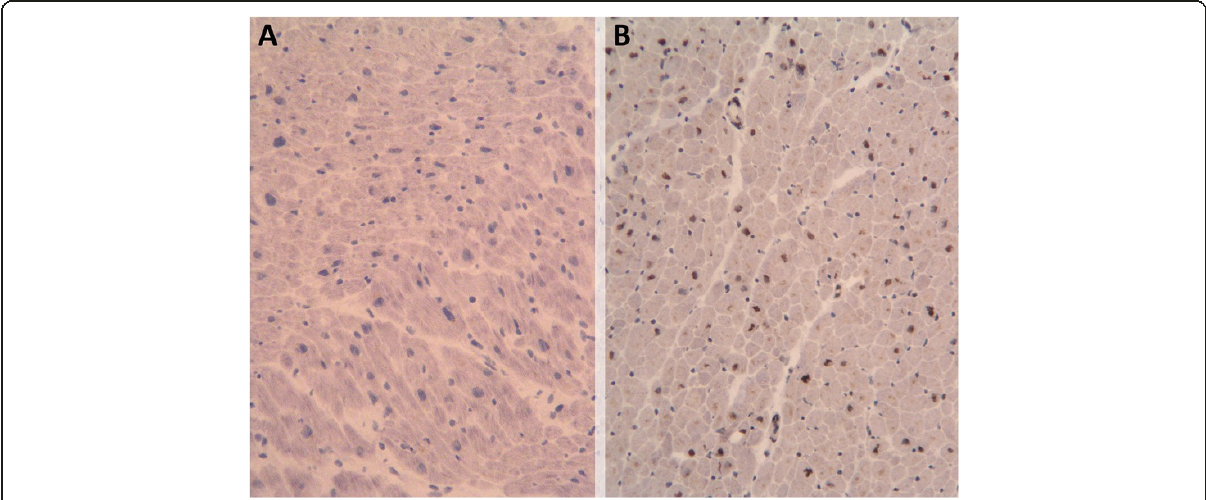
Figure 1 Insulin-like growth factor 1 (IGF-1) immunohistochemical expression in myocardium at 10 μ m (magnification ×100). (A) Negative control without IGF-1 antibody. (B) Positive control sample from a healthy donor with IGF-1